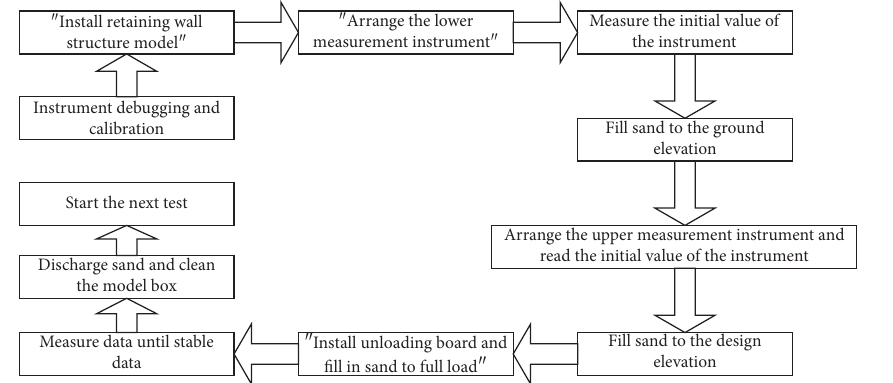
Figure 7: The flowchart of the test [26]. Table 3: The combined tests.